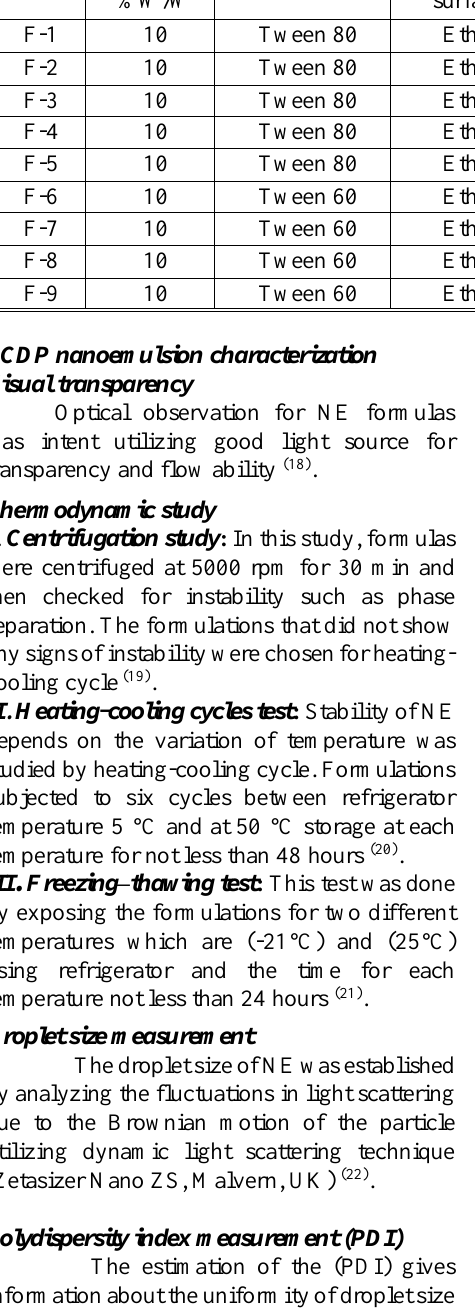
Table 1. Composition of LCDP Nanoemulsion